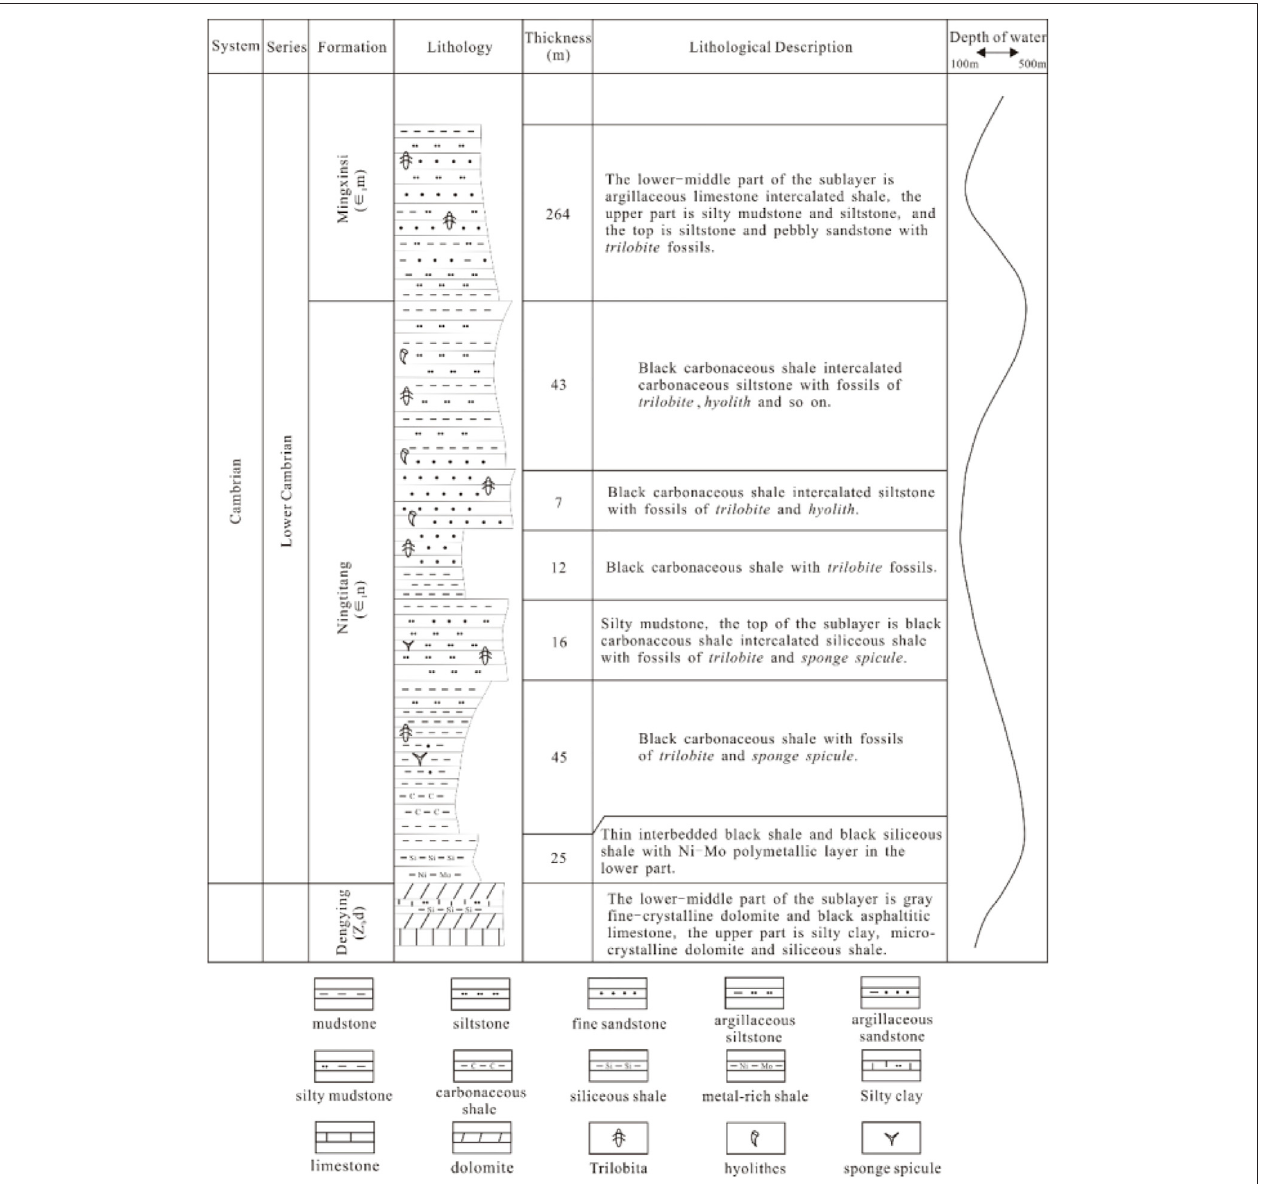
FIGURE 2 | Comprehensive stratigraphic column of the Niutitang Formation in Lower Cambrian of Guizhou Province (Modi fi ed by China ‘ s Stratigraphic Editorial Board, 2009).